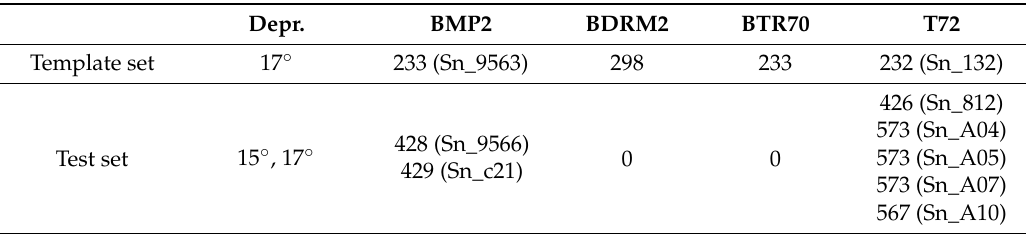
Table 5. Dataset of different